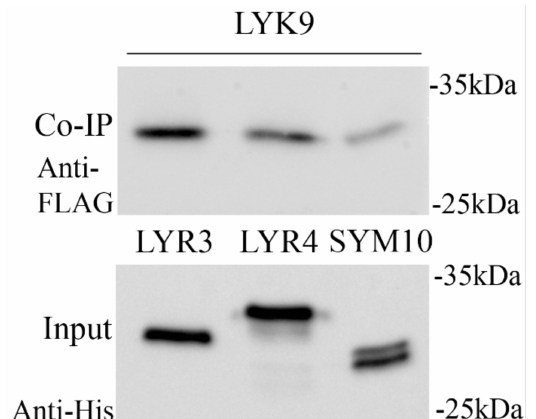
Figure 4. Analysis of complex formation between Ps LYK9-ECD tagged with FLAG and Ps LYR3-ECD, Ps LYR4-ECD, or Ps SYM10-ECD tagged with HIS determined by a co-immunoprecipitation assay. Extracellular domains of Ps LYK9, Ps LYR3, Ps LYR4, or Ps SYM10 were synthesized in E. coli . After ex- traction and incubation of the proteins on ice for 1 h, proteins were subjected to immunoprecipitation with anti-HIS resin and analyzed using immunoblotting with anti-FLAG and